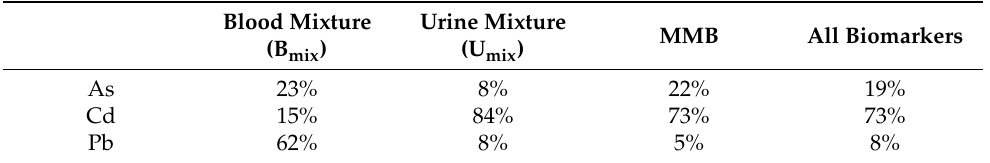
Table 5. Weights highlighting the contribution of each metal to the mixture effect of metals on Cystatin C. Larger weights indicated higher contributions to the mixture effect.